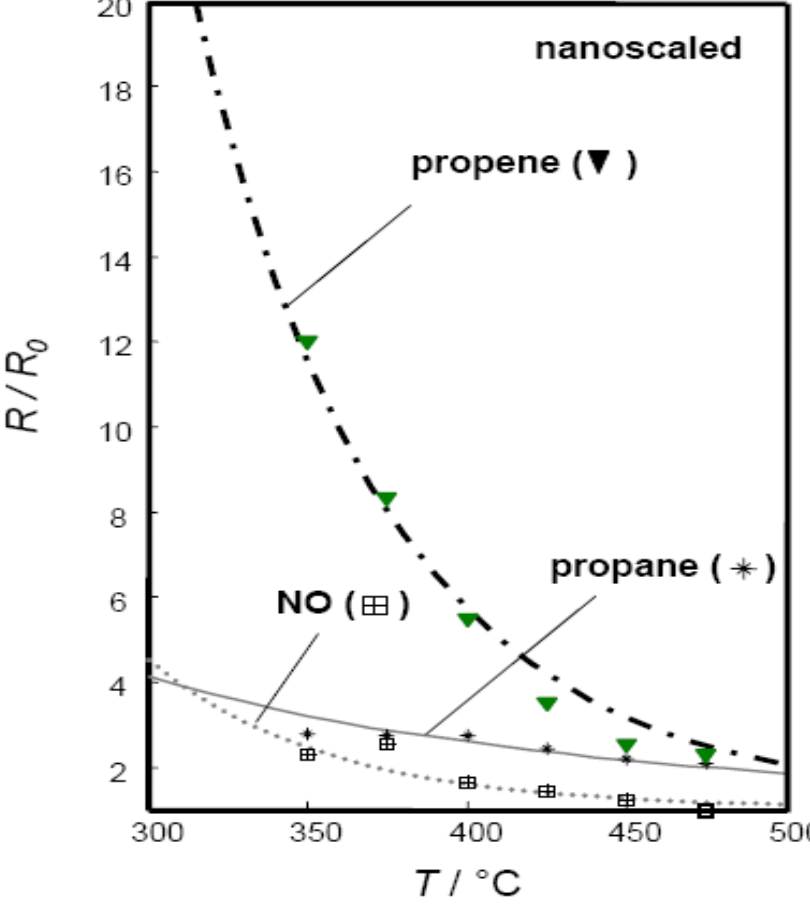
Fe O nanoscaled thick film, 0.8 0.2 3- d